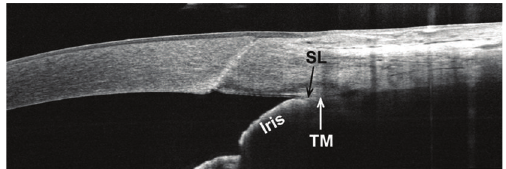
Figure 3: Frame-averaged cross-sectional OCT image of a closed angle with modified Sha ff er grade of 0 by gonioscopy. The high definition of the image allows the visualization of the Schwalbe’s line (SL) and the contact between the iris and the trabecular meshwork (TM). The AOD-SL is obviously zero in this case.